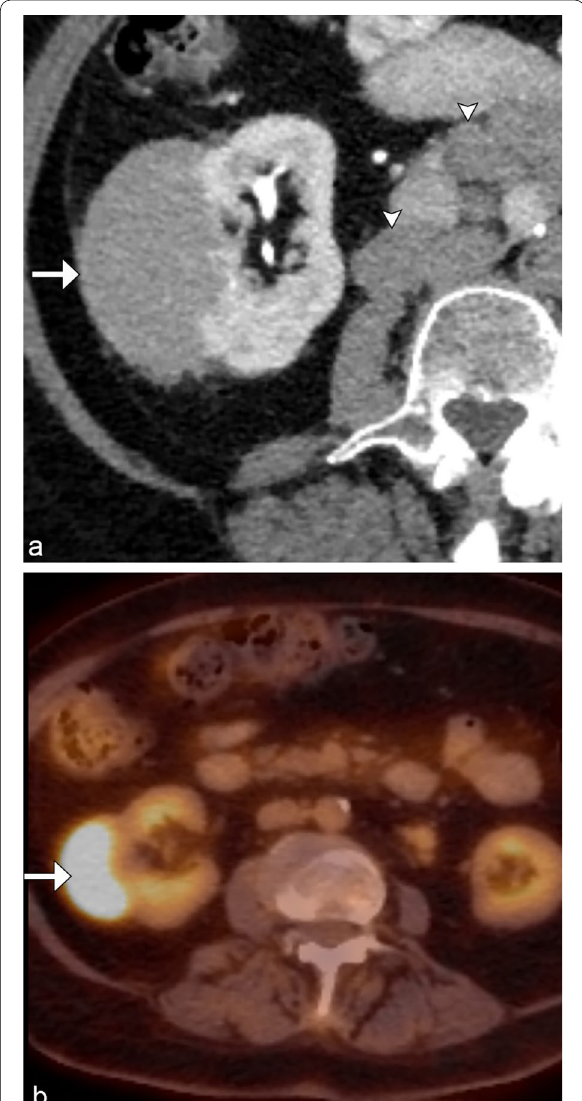
Fig. 2 Solitary mass of renal lymphoma. Axial contrast CT ( a ) demonstrates a solitary mass (arrow) in the right kidney with avid radiotracer uptake on F18-FDG PET/CT ( b ), as well as retroperitoneal adenopathy (arrowhead). This is consistent with solitary renal lymphomatous mass in this patient with marginal zone lymphoma. The marked FDG avidity differentiates it from typical renal cell carcinoma which can be mildly